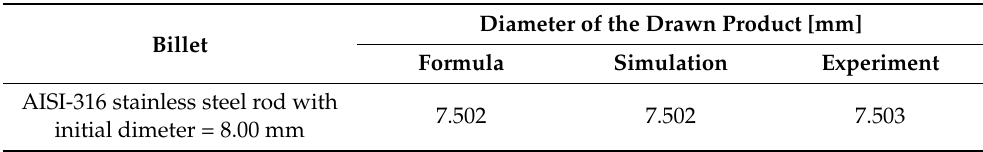
Table 2. Comparisons of product diameter between experiments, simulations and calculation results.